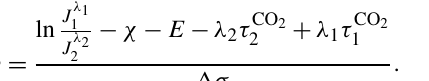
α , β and (cid:49)σ parameters: there is a reduction in the α and β parameters by a factor of about 50 from AIRWAVEv1